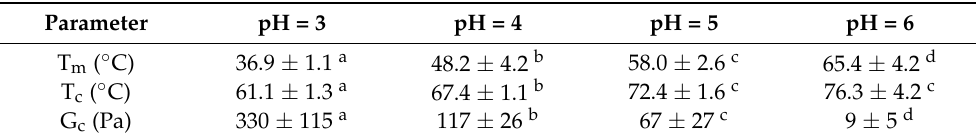
Table 2. Parameters for the systems gelled after the thermal cycle (pH 3, 4, 5, and 6). Values of temperature where G (cid:48) reaches the minimum in the temperature ramps (T m ) and where the storage and loss moduli are crossed (T c ), as well as the crossover value of the viscoelastic moduli (G c ) as a function of pH for the yolk acidulated with citric acid. Different letters within a row, indicate significant differences ( p <